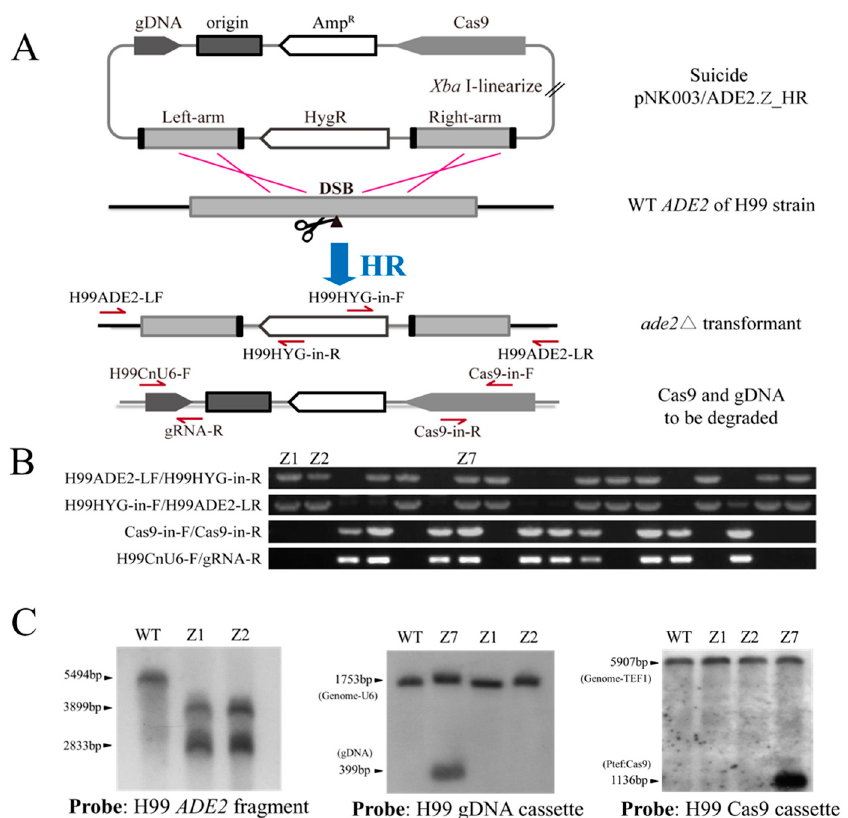
Figure 4. Disruption of the ADE2 gene in the H99 strain with the pNK003 plasmid. ( A ) Construction scheme used to produce the suicide plasmid based on the pNK003 vector. The left and right arms can be assembled into pNK003/ADE2.Z simultaneously using in-fusion cloning technology. CRISPR-Cas9 cassettes outside HR fragments would be resolved after double crossover. The primers used for PCR detection are indicated with arrows. ( B ) Four groups of PCR amplification were performed to verify the HR disruption of ADE2 (the two upper rows) and the elimination of Cas9 (the third row) and gDNA (the bottom row) in 18 pink transformants. The results show that 8/18 transformants had a disrupted ADE2 gene, and both Cas9 and gDNA were eliminated. The specific primer pairs are indicated on the left side of the gel. ( C ) Southern blotting was conducted to confirm that ADE2 was disrupted and CRISPR-Cas9 cassettes were eliminated. The left panel shows the disruption of ADE2 , in which genomic DNA was digested with EcoRI. The control WT had a wild-type ADE2 band (5494 bp), and the mutant strain had two bands (3899 bp and 2833 bp). The middle and the right panels show the loss of the gDNA and Cas9 cassettes in the Z1 and Z2 mutants.